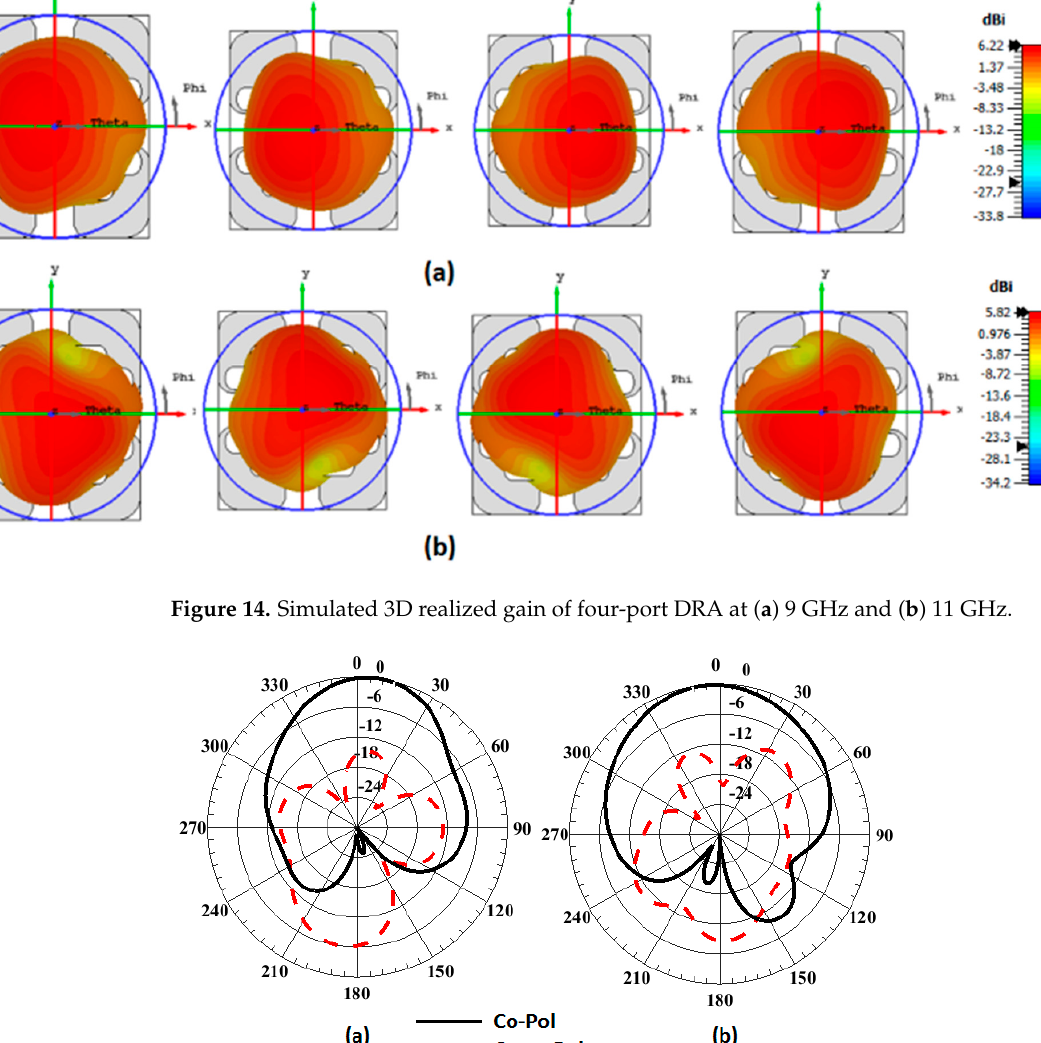
Figure 15. Simulated field pattern of the four ports DRA at 9.77 GH in ( a ) φ = 0° and ( b ) φ = 90° plane (with the applied input at Port 1 and keeping the other terminated with the matched load).